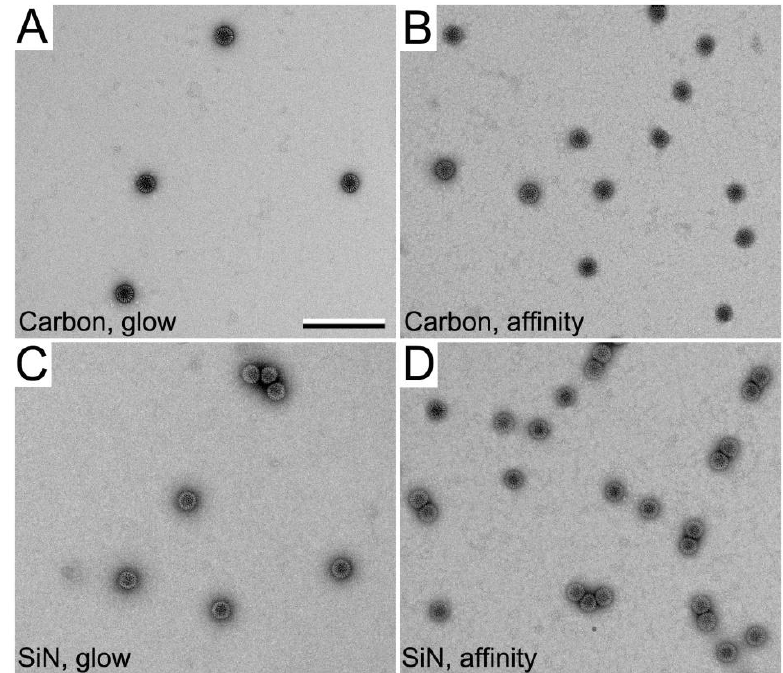
Figure 4. ( A ) Representative low-magnification images (13,000×) of negatively stained EM specimens indicated less DLPs adhered to glow-discharged carbon support films than to Affinity Grids coated with Ni-NTA and decorated with molecular adaptors ( B ). DLPs adhered similarly to glow-discharged SiN microchips ( C ) and to glow-discharged carbon films. ( D ) SiN Affinity chips coated with Ni-NTA and decorated with molecular adaptors recruited the greatest number of DLPs using equivalent amounts of material. Scale bar is 300